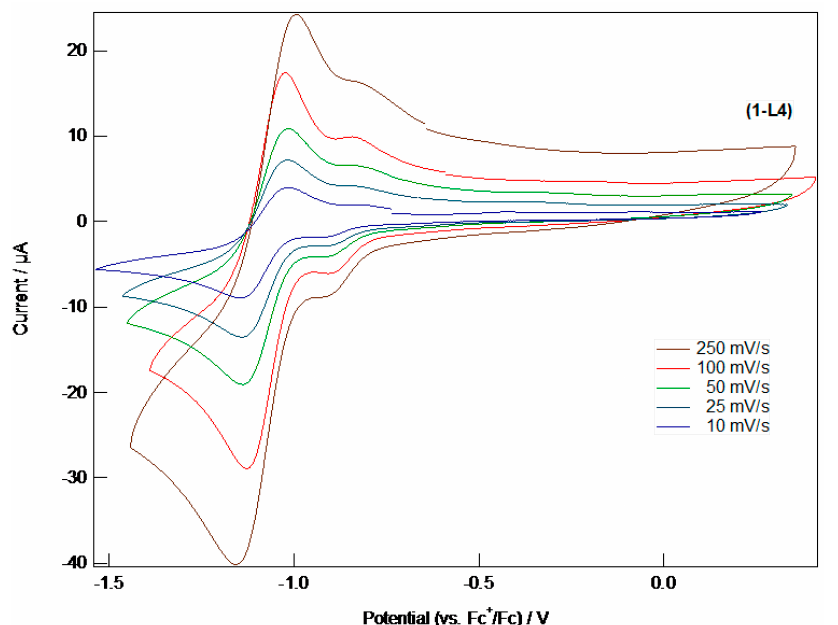
Figure 1. Graphical representation of ( 1-L4 ) ( top ) and space filling representation of the pi-stacked dimers observed in the solid state ( bottom ). Mo = Orange spheres; O = Red spheres; N = Blue sphere, C = Black spheres; S = Yellow sphere; Br = Teal sphere; H = White spheres [29].